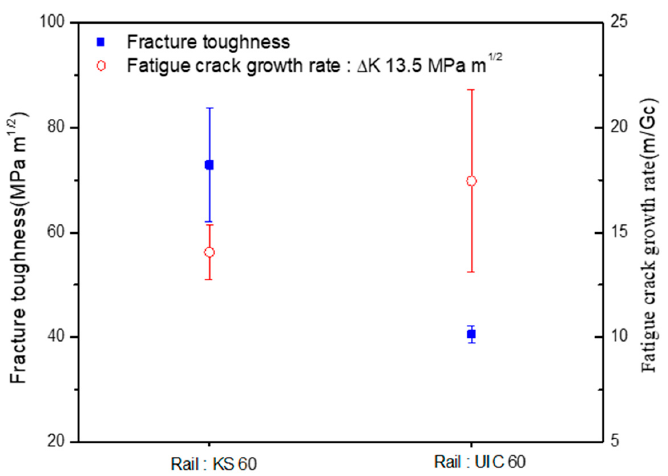
Figure 21. Microstructure and cracks generated on the surfaces of wheel and rail specimens: ( a ) wheel specimen (R7); ( b ) Rail specimen (UIC60).